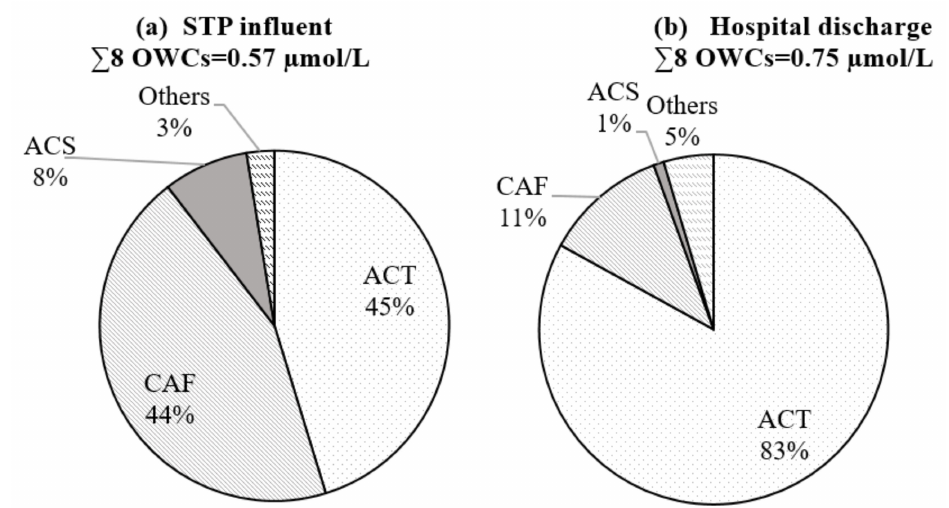
Figure 1. Relative contributions of targeted compounds in ( a ) raw sewage (STP influent) and ( b ) hospital